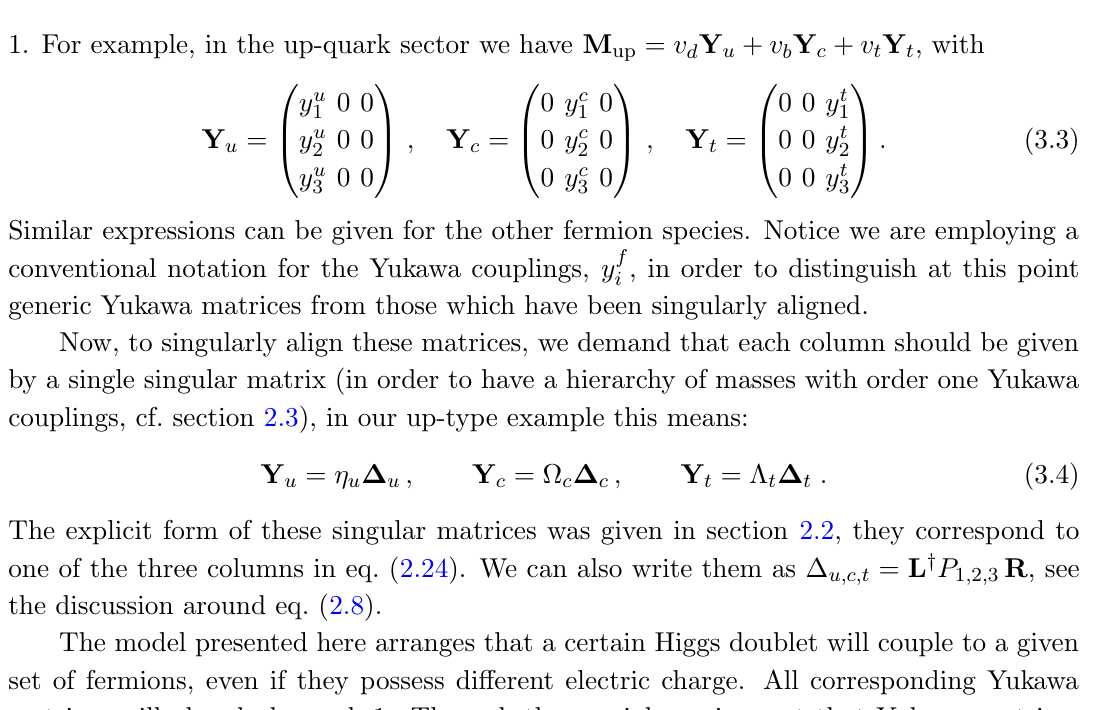
Table 1 . Charge assignment under the discrete (cid:13)avour symmetry group Z 2 (cid:2) Z 0 di(cid:11)erent scalar and fermion (cid:12)elds in the 4HDM with rank one Yukawa matrices. This extension to the SM comprises 3 right-handed neutrinos and 3 new Higgs (cid:12)elds.